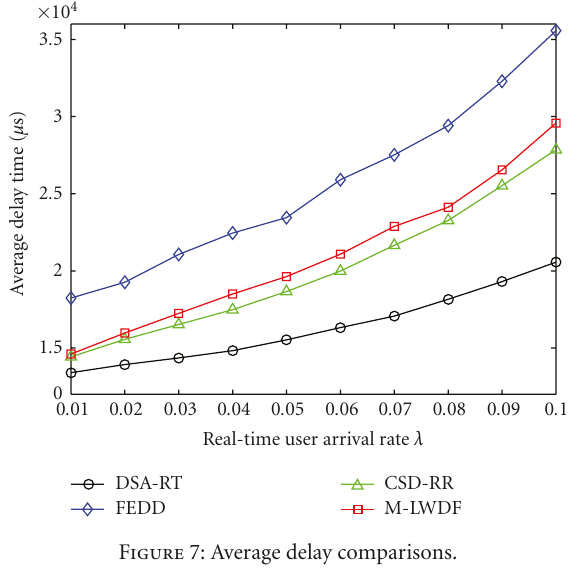
Figure 7: Average delay comparisons.